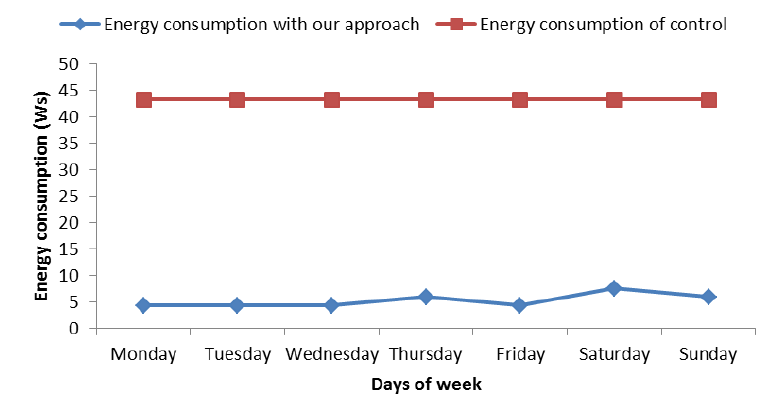
Figure 12. Energy consumption from 28 May to 3